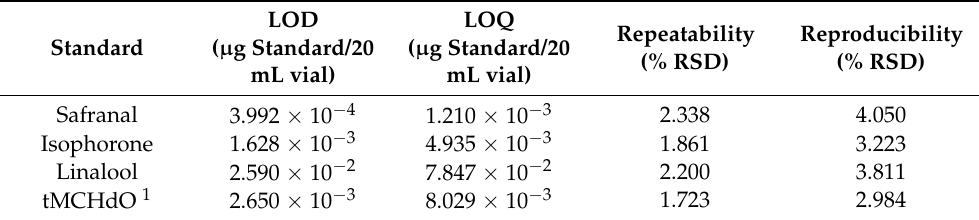
Table 2. Sensitivity and precision of the experimental procedure for analysis by headspace-stir bar sorptive extraction-gas chromatography/mass